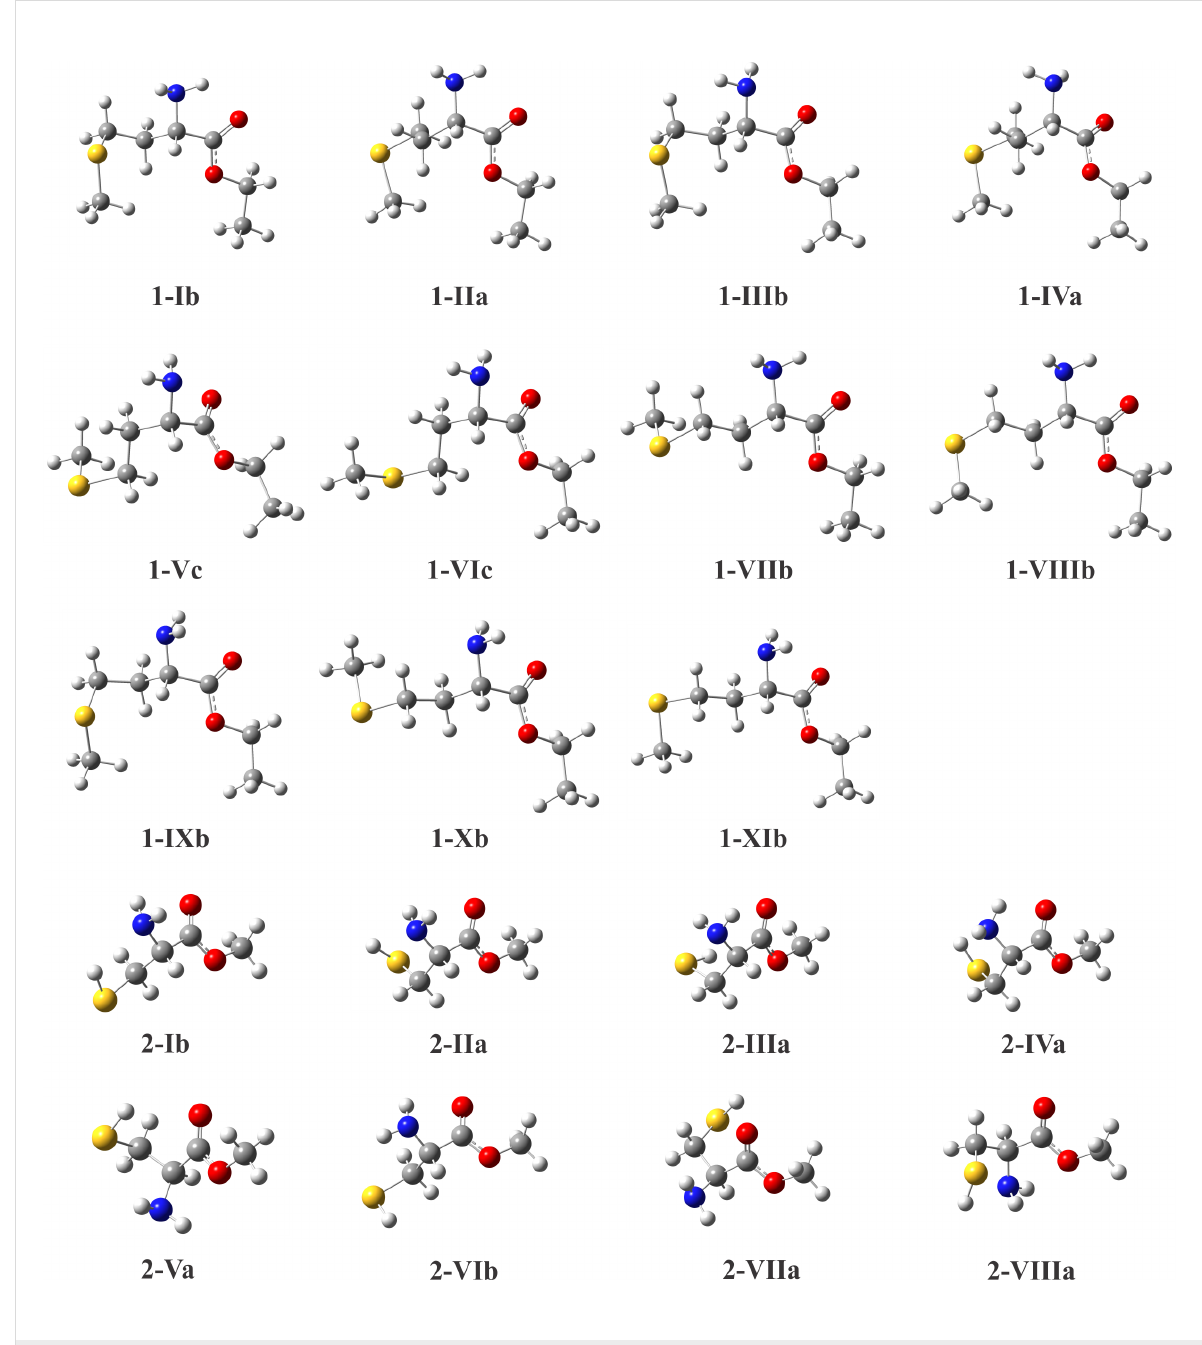
Figure 1: Most stable conformers of 1 and 2 obtained theoretically at the ω B97X-D/aug-cc-pVTZ level.